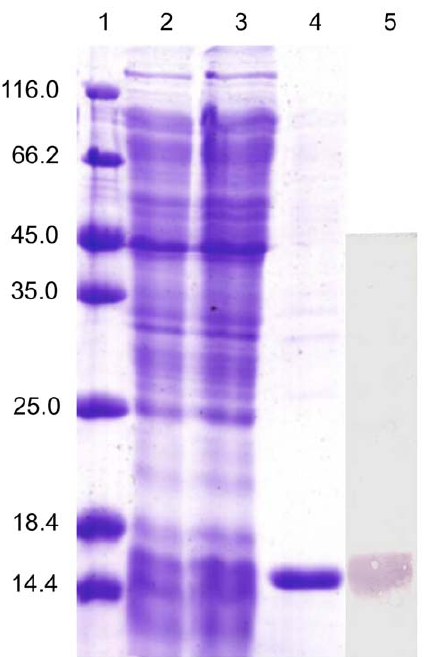
Figure 3. SDS-PAGE and western-blot analysis of rCfC1qDC. Lane 1: protein molecular standard (kDa); lane 2: negative control for rCfC1qDC (without induction); lane 3: induced rCfC1qDC; lane 4: purified rCfC1qDC; lane 5: western blot based on the sample of line 3.